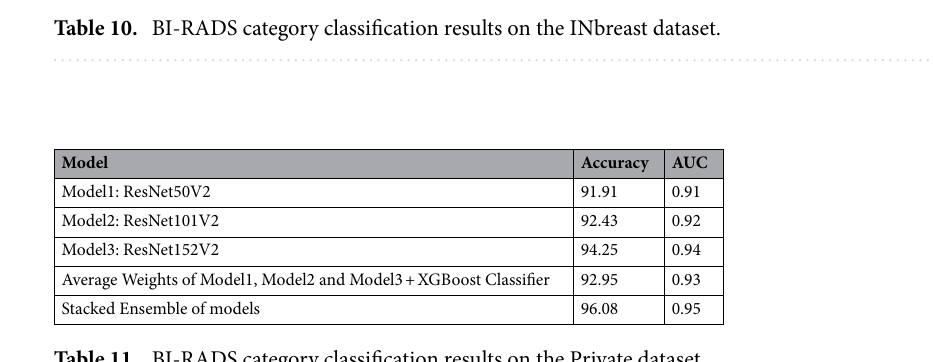
Table 11. BI-RADS category classification results on the Private